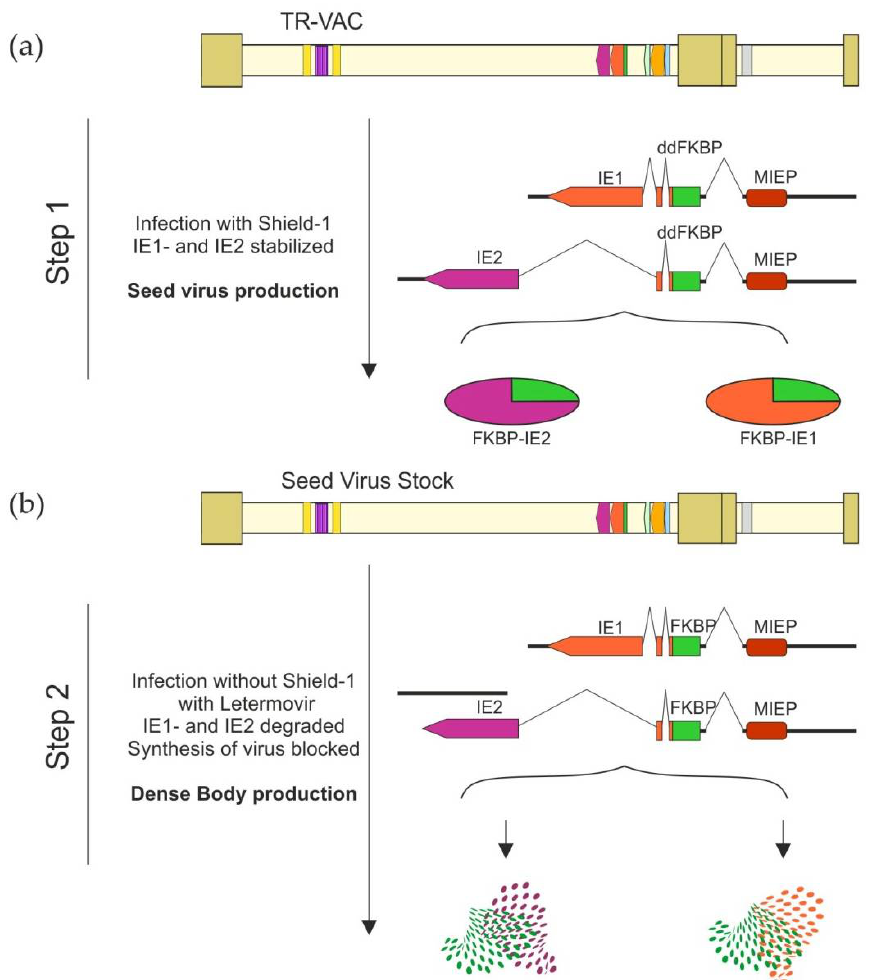
Figure 10. Schematic representation of the production strategy of the TR-VAC DB as a potential vaccine. ( a ) Production of a seed virus. The structures of the ddFKBP-IE1 and ddFKBP-IE2 fusion genes are shown. The splicing events are depicted by the bent light solid lines. The fusion proteins are schematically displayed. ( b ) Production of the TR-VAC DB-based vaccine candidate. HFF are infected with TR-VAC without Shield-1 but in the presence of LMV. This results in the degradation of IE1 and IE2 and diminished viral replication, while DB production is not impaired.